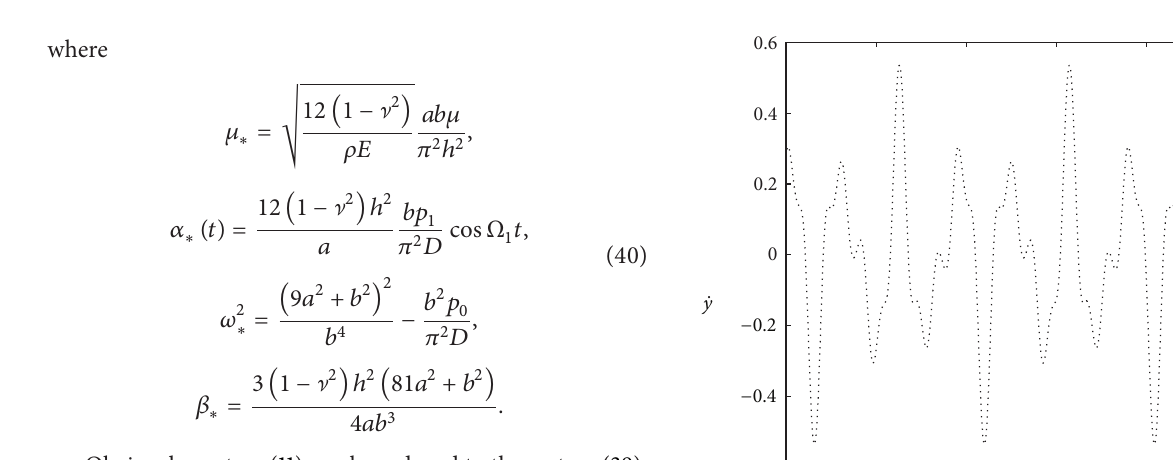
Figure 2: Phase portrait for (𝑦, ̇𝑦) .